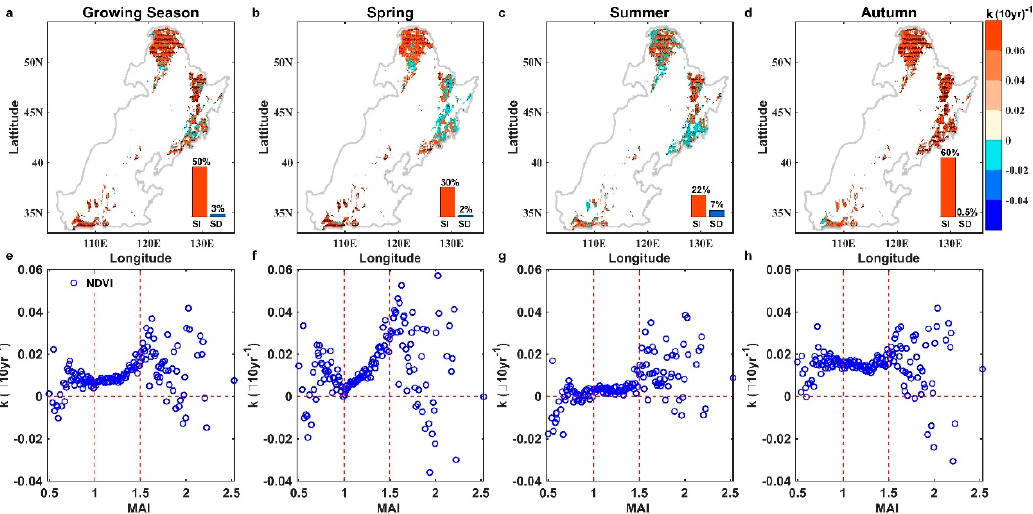
Figure 4. The spatial distribution of the linear trends in NDVI in different seasons over northeastern China ( a – d ) and the distribution of linear trends in NDVI along with multi-year mean aridity index (MAI) ( e – h ). Black points in a-d indicate that the trends of NDVI are statistically significant ( p < 0.05), and the inset shows the area proportions (values above the bar) with significant increase (SI) and significant decrease (SD) slopes at p < 0.05, respectively. k on the y -axis ( e – h ) is the slope of the linear fitting, and the blue dots represent the slope values of NDVI. The red dashed lines indicate the lines of MAI = 1.0 and MAI = 1.5, respectively, which represent the thresholds for different drought regions. During past decades, the air temperature, moisture conditions (here represented by WD), and solar radiation have undergone tremendous changes in our study region, with great differences in temporal trends (Figures S2 and S3; Table 2). In spring, temperature exerted significantly positive effects on NDVI in humid (MAI < 1.0) and semi-humid (1.0 < MAI < 1.5) regions, with partial correlation coefficients (PR) of 0.66 ( p < 0.05) and 0.63 ( p < 0.05) (Figure 5), and contribution rates (CB) of 38.26% and 33.95%, respectively (Figure 6); whereas, NDVI exhibited significantly positive partial correlations with WD and SR in semi-arid regions in spring, with a PR of 0.46 ( p < 0.05) and 0.38 ( p < 0.05), respectively (Figure 5b). In summer, NDVI was significantly and positively correlated